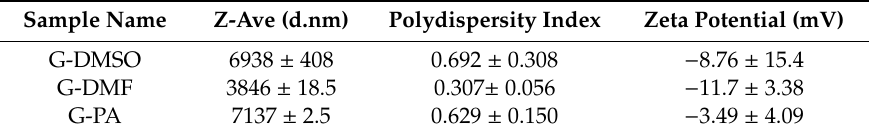
Table 1. Dynamic light scattering analysis of the obtained graphene